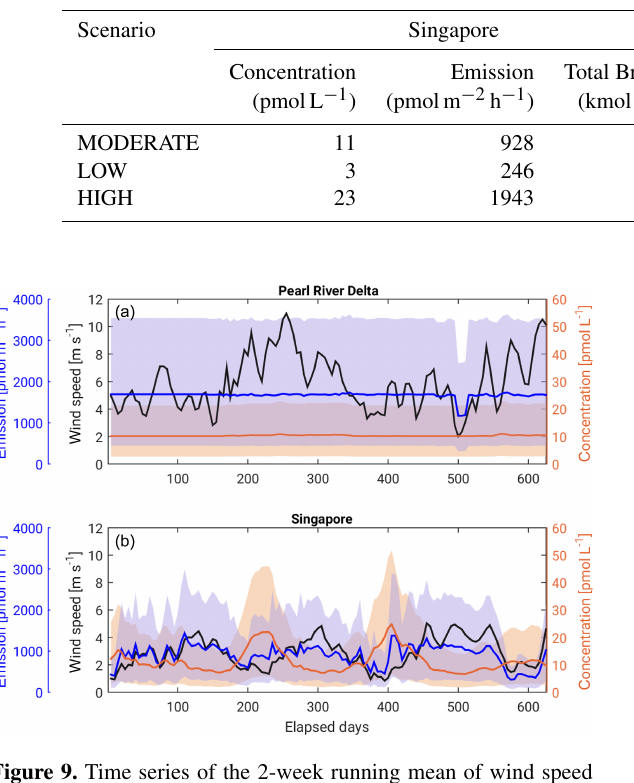
Figure 9. Time series of the 2-week running mean of wind speed (black), bromoform surface concentration (orange) and emissions (blue) for (a) Singapore and (b) Pearl River Delta. Solid lines show values from the MODERATE scenario. Shaded areas show the range between the HIGH and LOW scenarios for both bromo- form concentration and emissions.